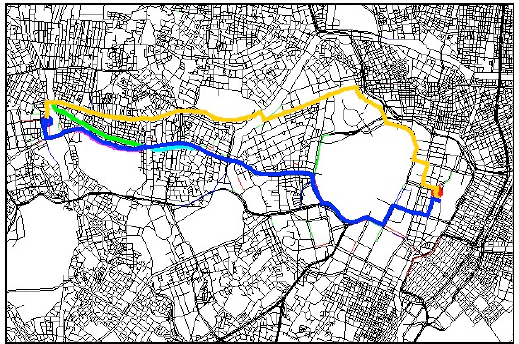
Figure 14. Routes generated by the proposed method in Tokyo